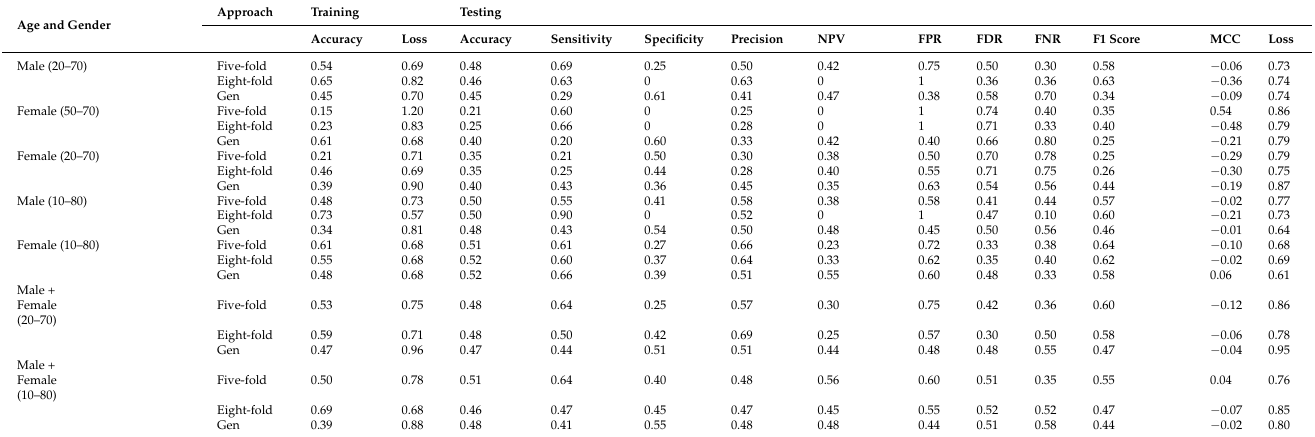
Table 7. ResNet output using age and gender (Gen = Generalization approach).